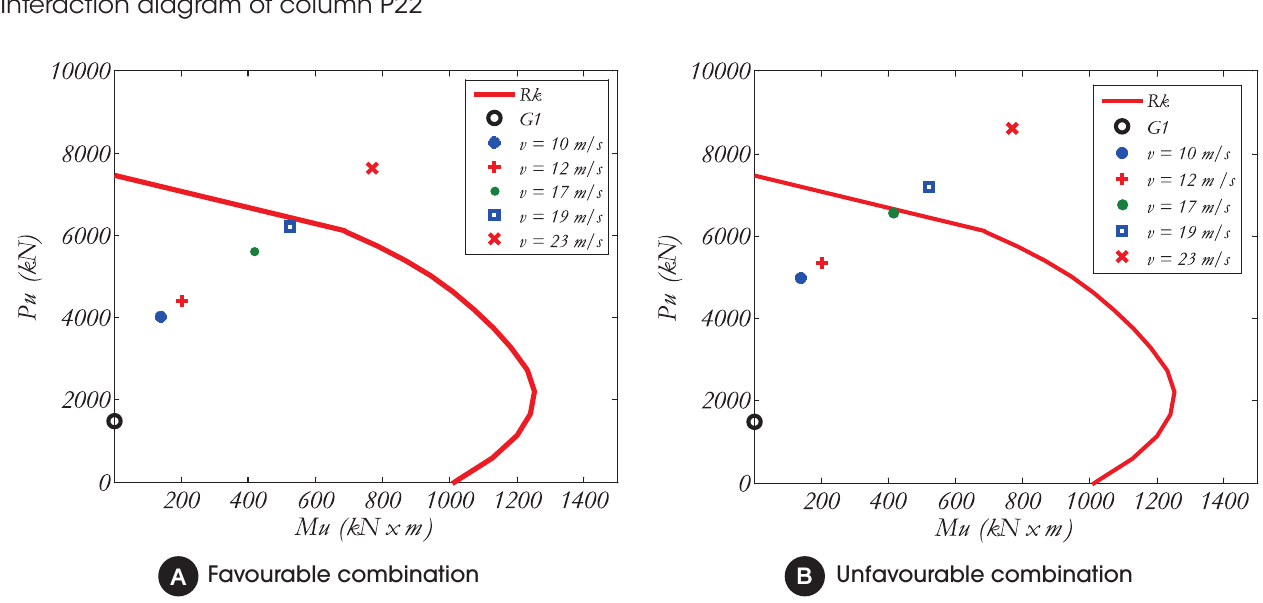
Interaction diagram of column P04 under frequent wind gust velocities